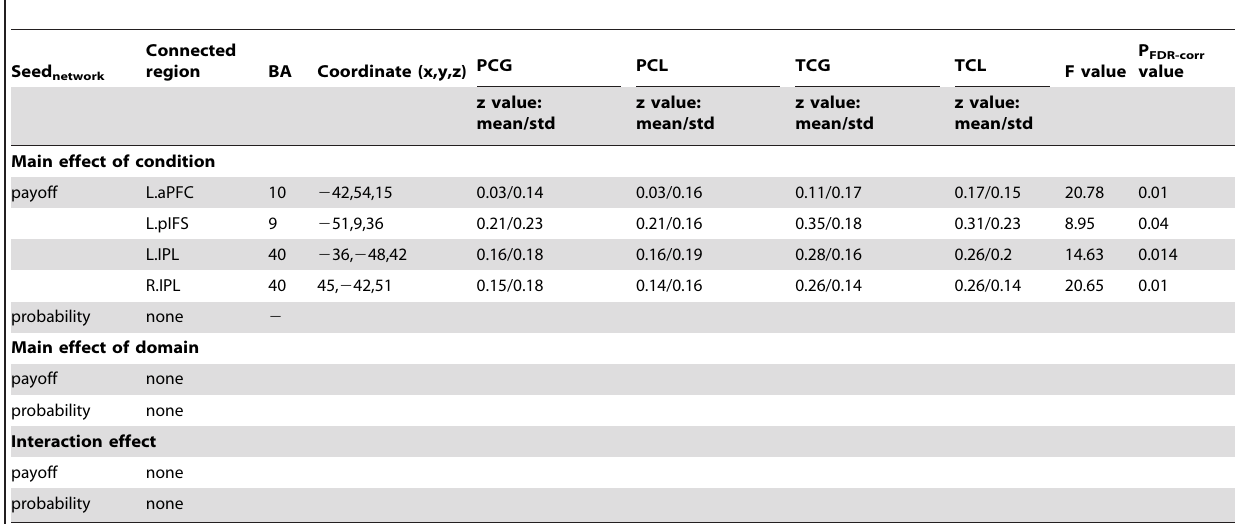
Table 2. Differences in functional connectivity associated with the payoff network or the probability network (p , 0.05, corrected by